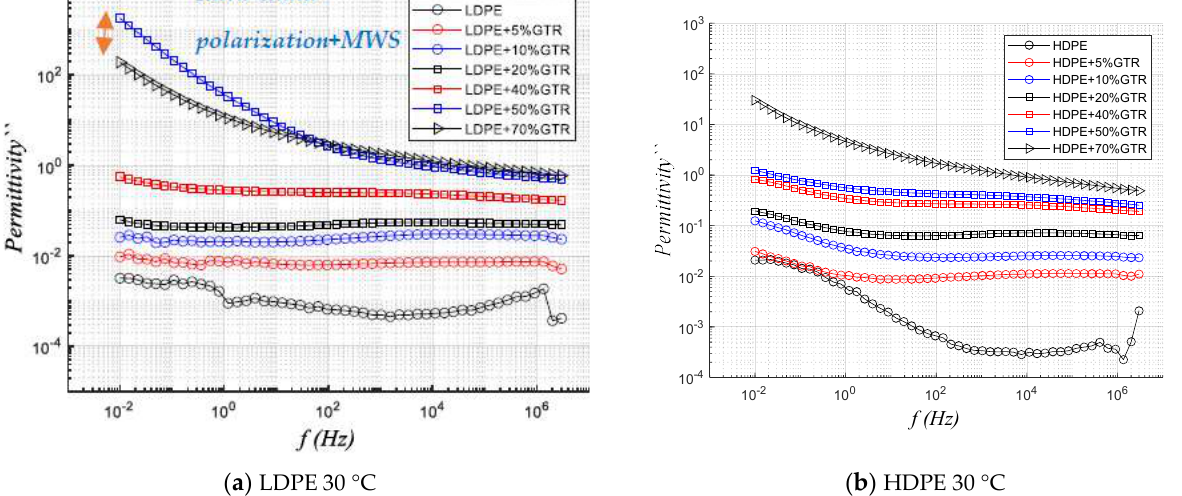
Figure 5. Frequency dependence response of real permittivity, at 30 °C of ( a ) LDPE/GTR compounds and ( b ) HDPE/GTR compounds.